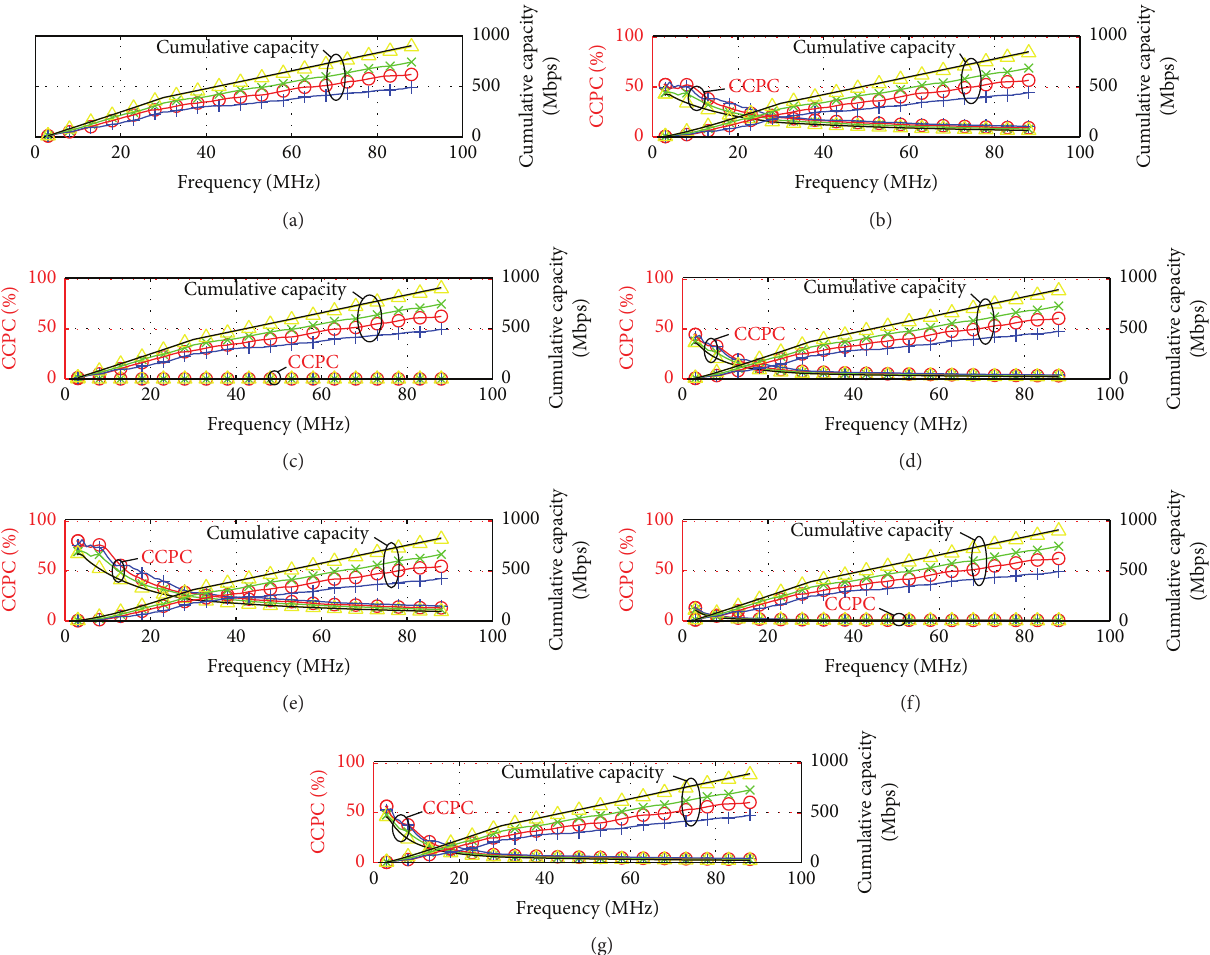
Figure 5: Cumulative capacity and CCPC versus frequency of the indicative topologies of OV MV BPL networks, urban case A (red circle), urban case B (blue cross), suburban case (green star), rural case (yellow triangle), and LOS case (black line), in the 3–88 MHz frequency band for the seven aforementioned noise models when respective WtG 1 / StP 1 coupling schemes are deployed, average noise type is assumed, and FCC Part 15 is adopted. (a) FL noise model (with no CCPC curves). (b) OPERA noise model. (c) MEN noise model. (d) PH1 noise